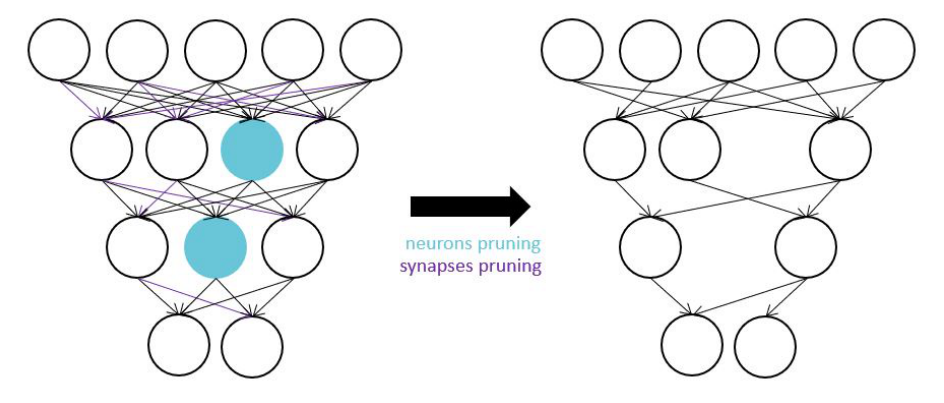
Figure 6. Architecture of an MLP before and after pruning—synapses and neurons pruning.